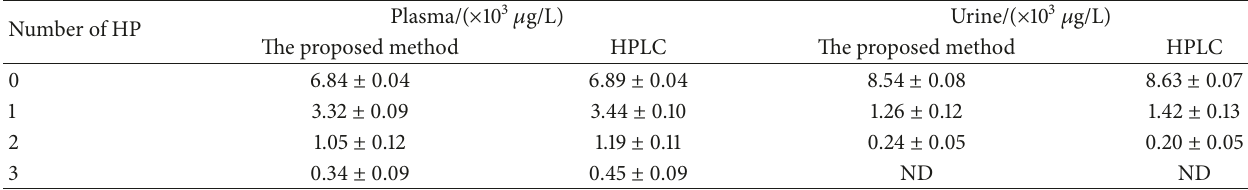
Table 4: Determination of PQ in plasma and urine sample with different hemoperfusion numbers by the proposed method and HPLC ( 𝑛 = 3